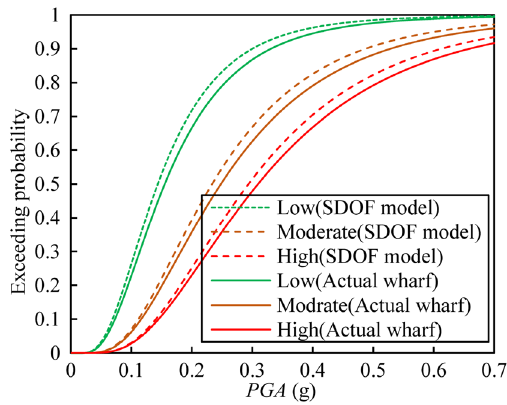
Fig. 14 Fragility curves for case study